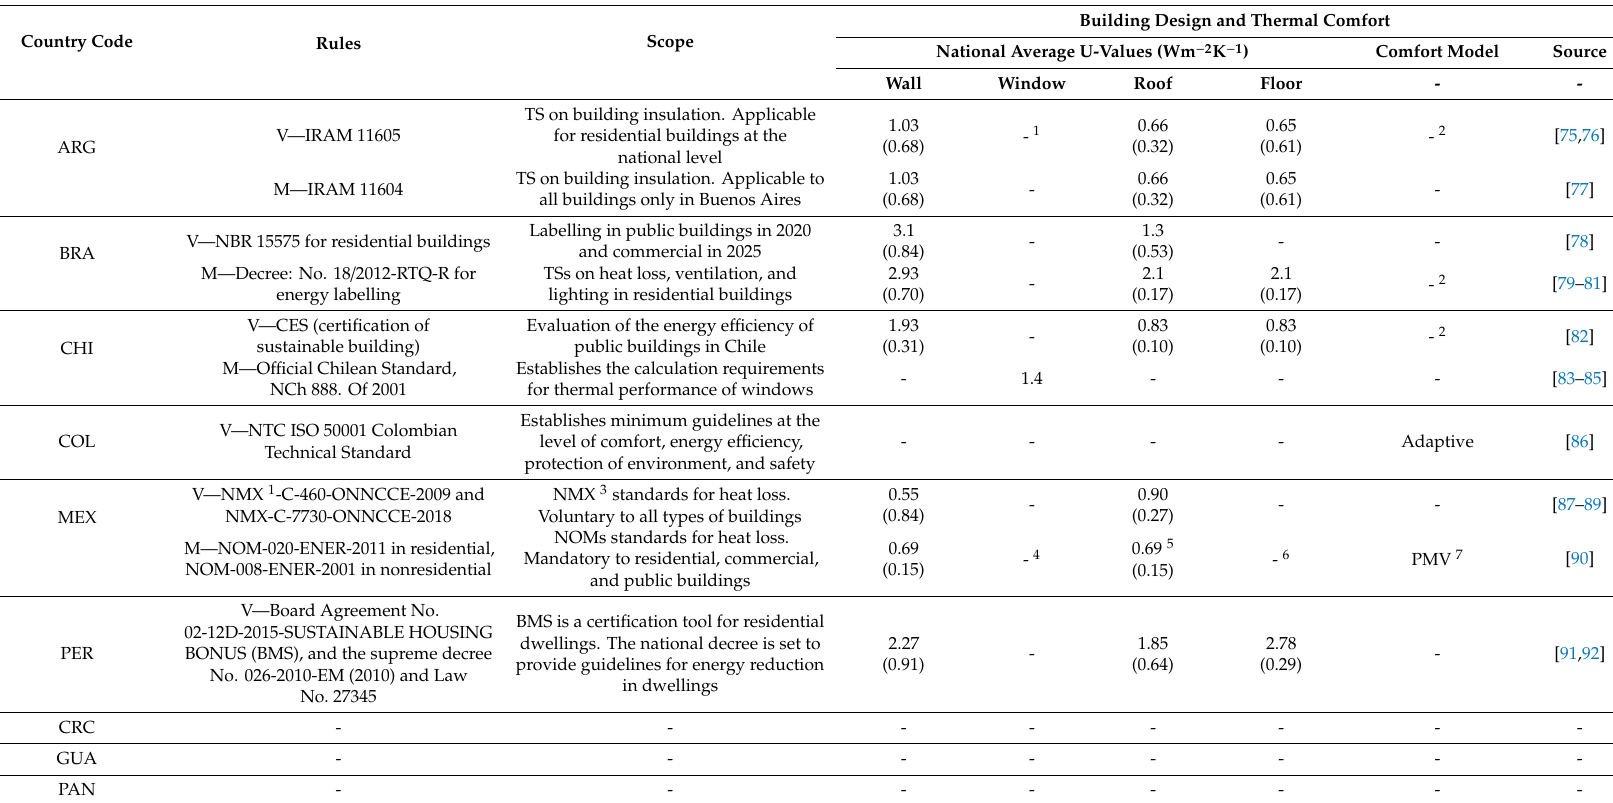
Table 3. Comparison of the di ff erent rules that deal with heat loss in the building fabric, where M stands for mandatory (e.g., a minimum energy performance standard (MEPS)) and V stands for voluntary (e.g., an energy rating system (ERS)). Numbers in brackets for U-values indicate standard deviations and demonstrate climatic variations within the national